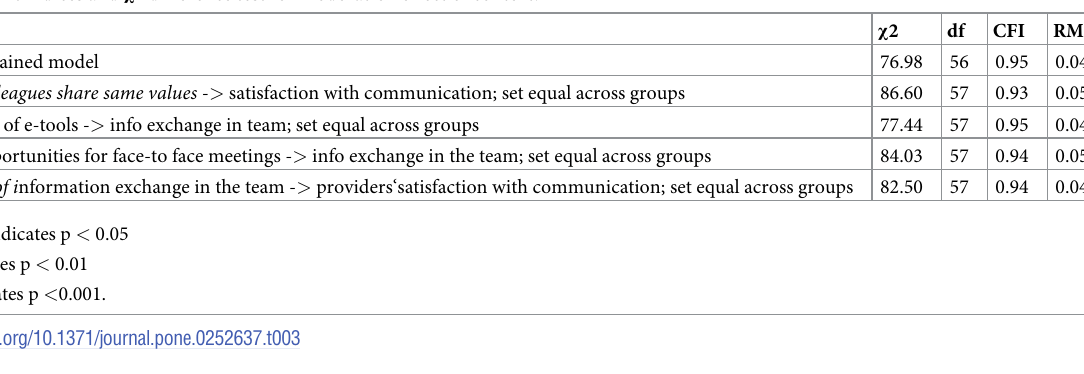
Table 3. Fit indices and χ 2 difference test for moderation effect of